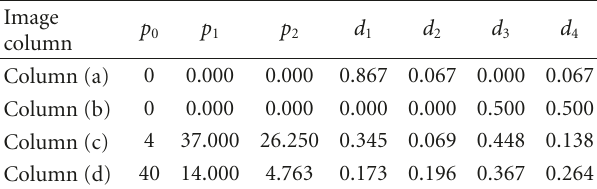
Table 1: Feature values corresponding to the images in Figure